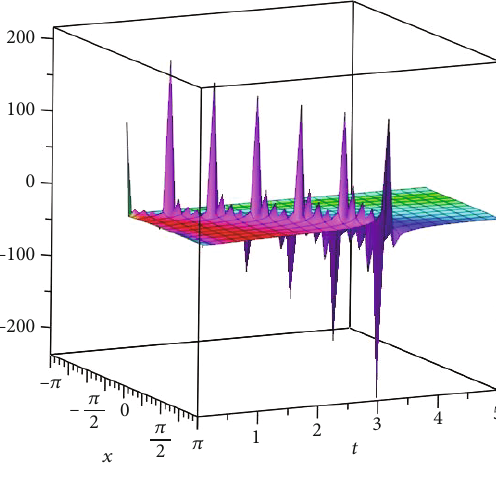
ð x , y , t Þ given by 2